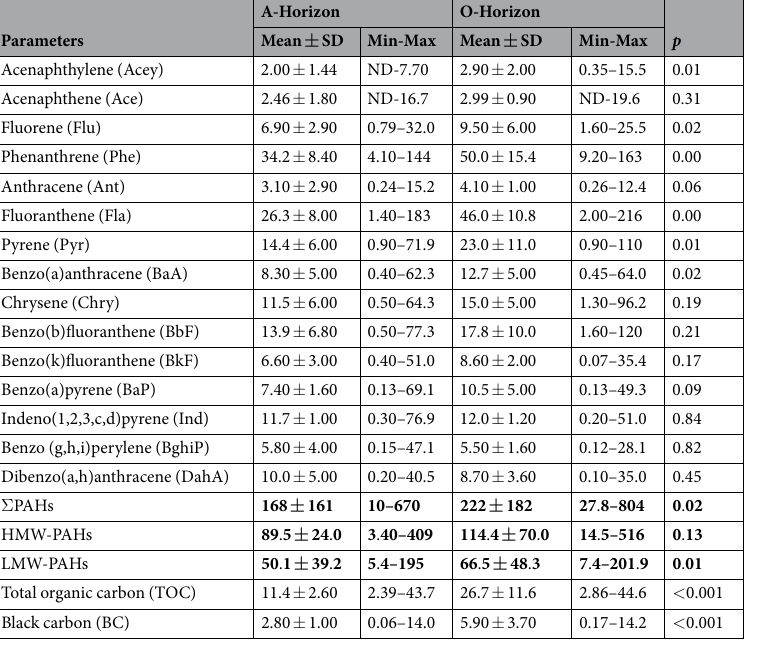
Table 1. Comparative description of individual and ∑ 15 PAHs (ng g − 1 ), TOC ( % ) and BC ( ug g − 1 ) detected in A- and O-horizons of forest soils. p = Probability value, significant when < 0.05 (independent sample t-test); Σ PAH = sum of non-alkylated total PAHs. L MW-PAHs = low molecular weight PAHs. HMW-PAHs = high molecular weight PAH. ND = Not Detected ( < detection